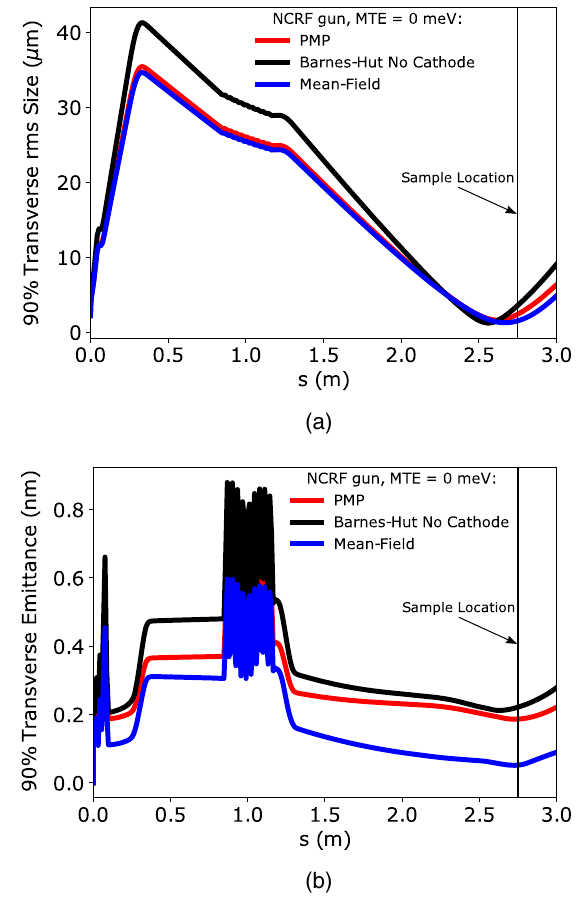
FIG. 5. (a) Spot size and (b) transverse normalized rms emittance comparison between the PMP method, Barnes-Hut method without a cathode, and mean-field space charge simu- lations of the NCRF UED beamline with 0 meV MTE.